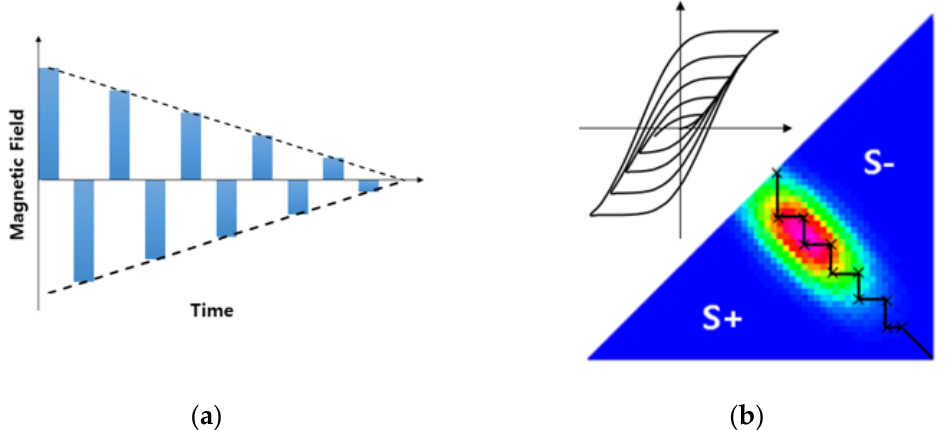
Figure 7. The trace depending on the complex inputs on the Preisach plane: ( a ) applied magnetic fields and ( b ) the traces according to the applied magnetic fields on the Preisach plane.